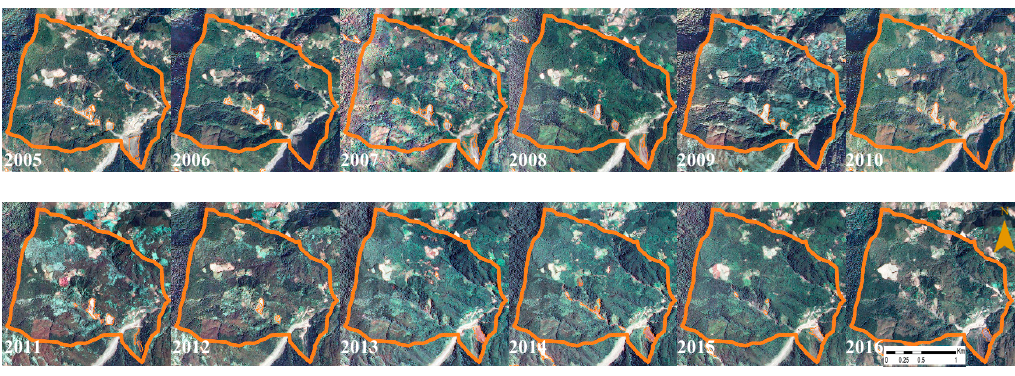
Figure 11. The annual thumbnail images overlaid with the corresponding landslide polygons in optimum sub-watershed No. 21735, which is categorized as a severe landslide area with a level of instability of 4.